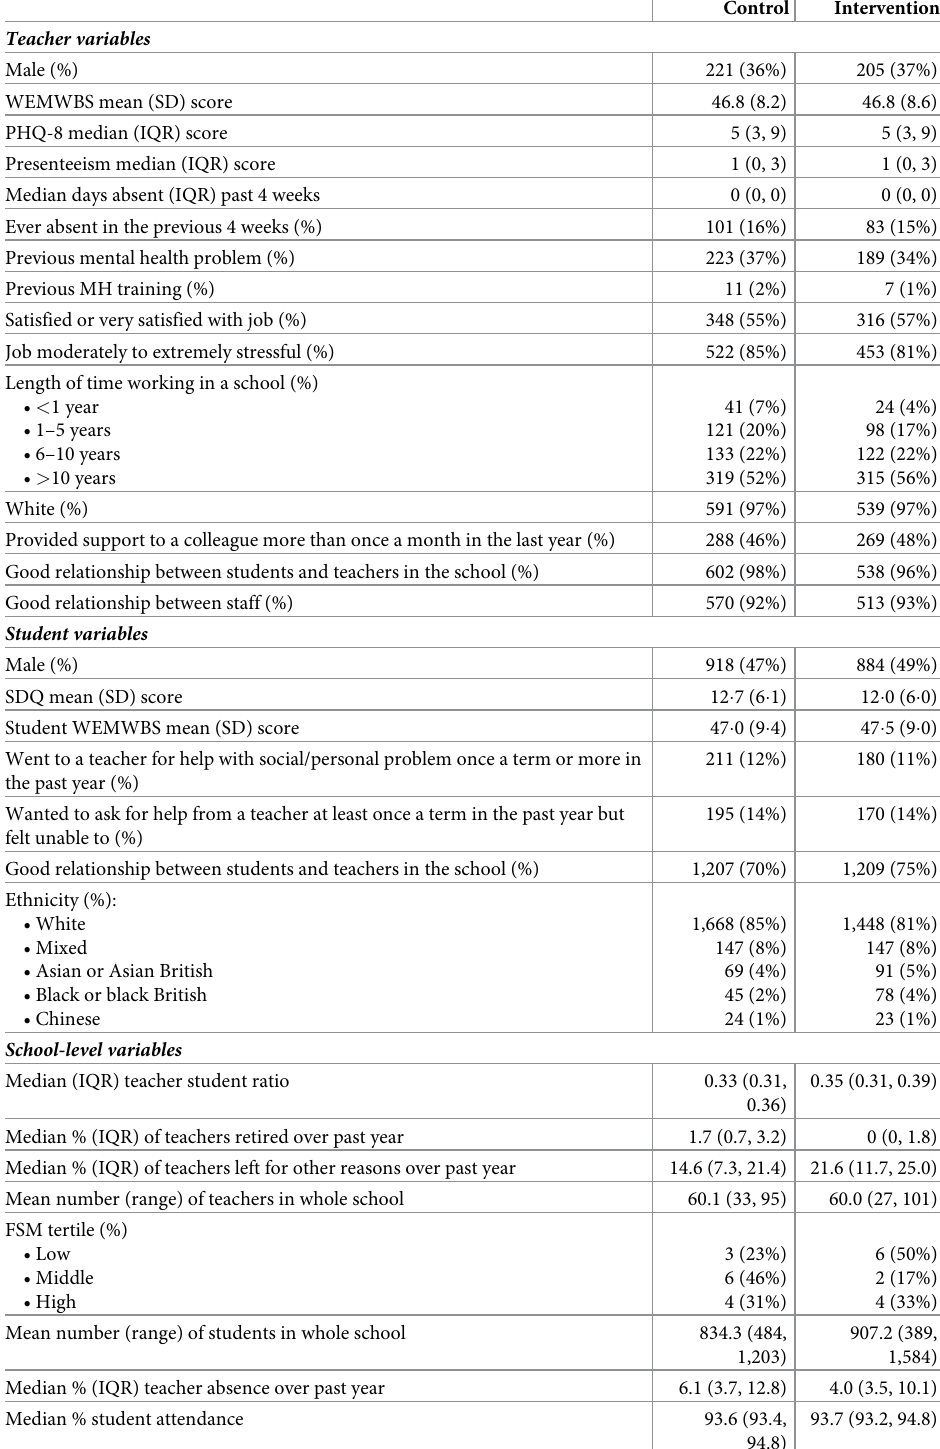
Table 1. Comparison of baseline characteristics between